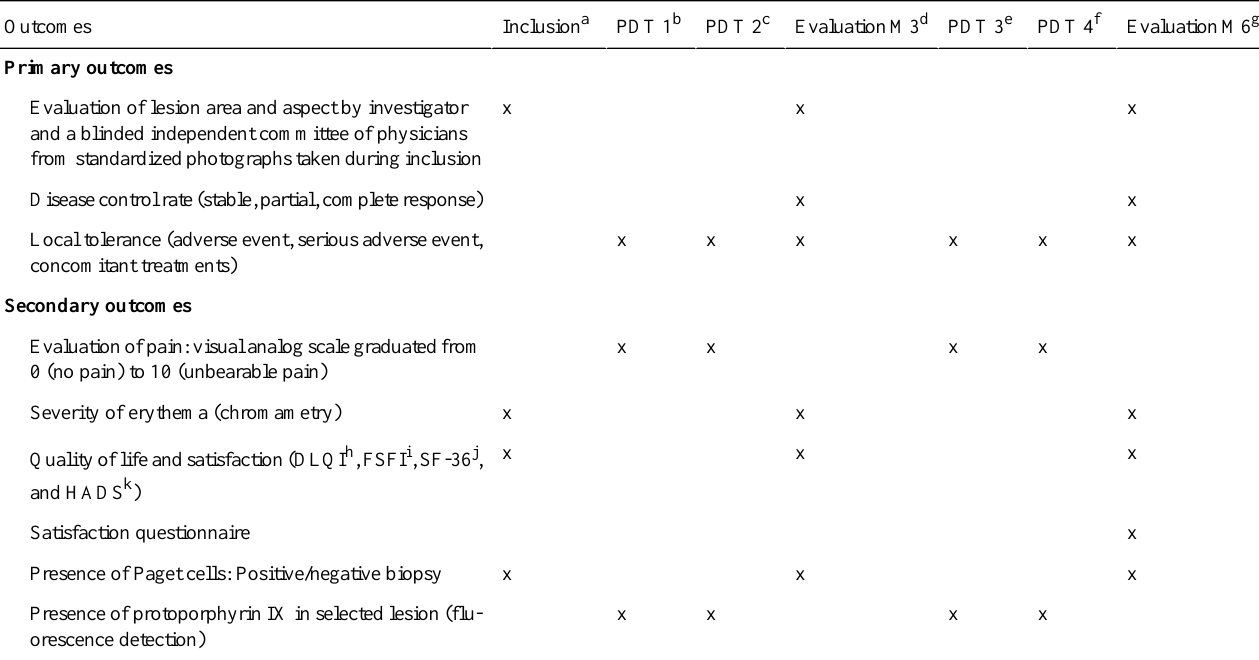
Table 1. Outcomes and